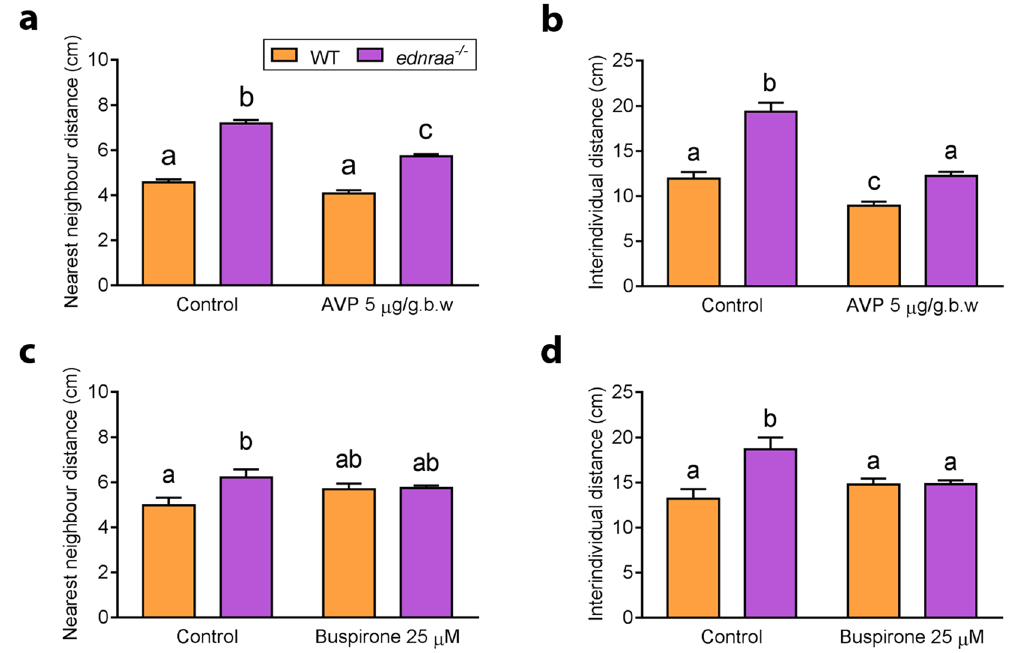
Figure 9. Treatment with AVP or buspirone rescues the shoaling phenotype of ednraa − / − . ( a , b) Injection of AVP reduces the nearest neighbour- and inter-individual distances in both WT and ednraa − / − . However, ednraa − / − still exhibit increased NND and IID compared to WT. (c , d) Acute immersion in buspirone